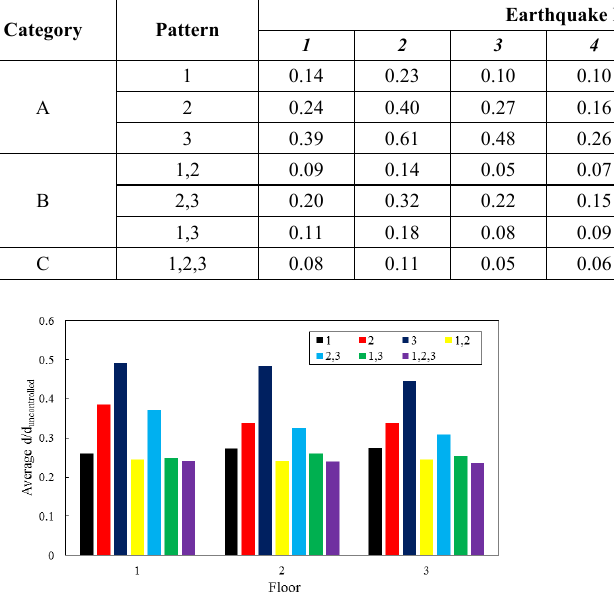
TABLE IV. A CCELERATION COMPARISONS ( RELATIVE TO UNCONTROLLED RESPONSE ) BETWEEN DIFFERENT PLACEMENT PATTERNS Earthquake ID (refer to table 2) Category Pattern 1